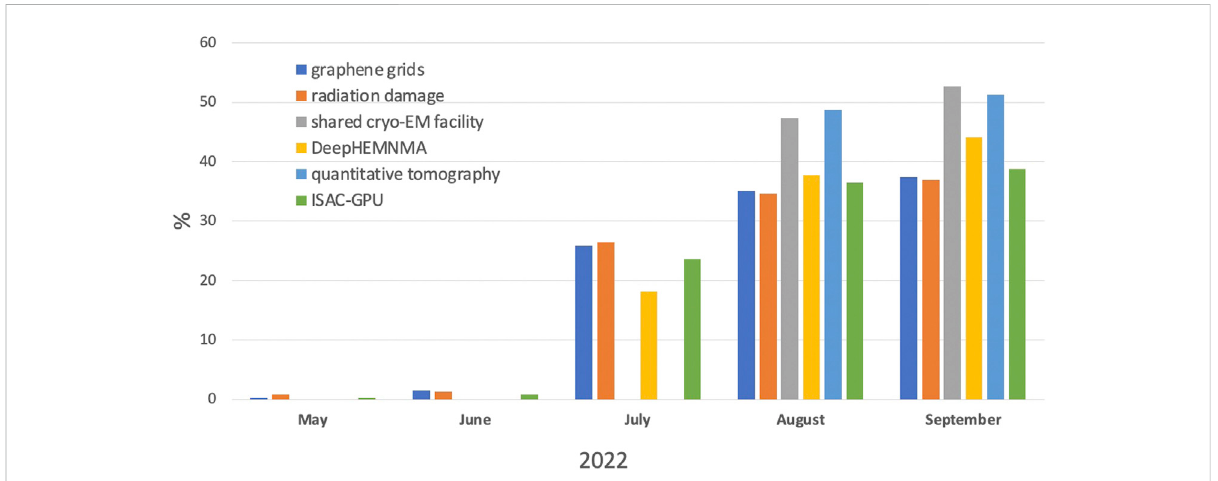
FIGURE 1 Views of papers, accepted to the Research Topic Methods in Structural Biology: Cryo-EM, according to Frontiers impact score per month in % to the total number of